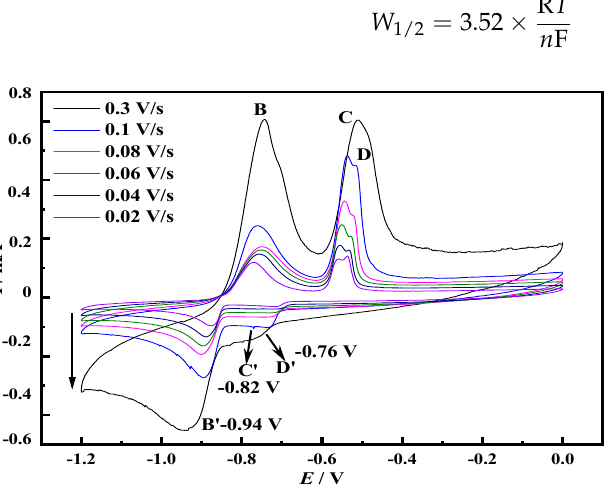
Figure 3. Cyclic voltammetry curves at different scanning speeds ( T = 30 °C; WE: glassy carbon electrode; CE: platinum; RE: Hg/HgO (0.098 V); scan rate: 0.02–0.3 V/s).